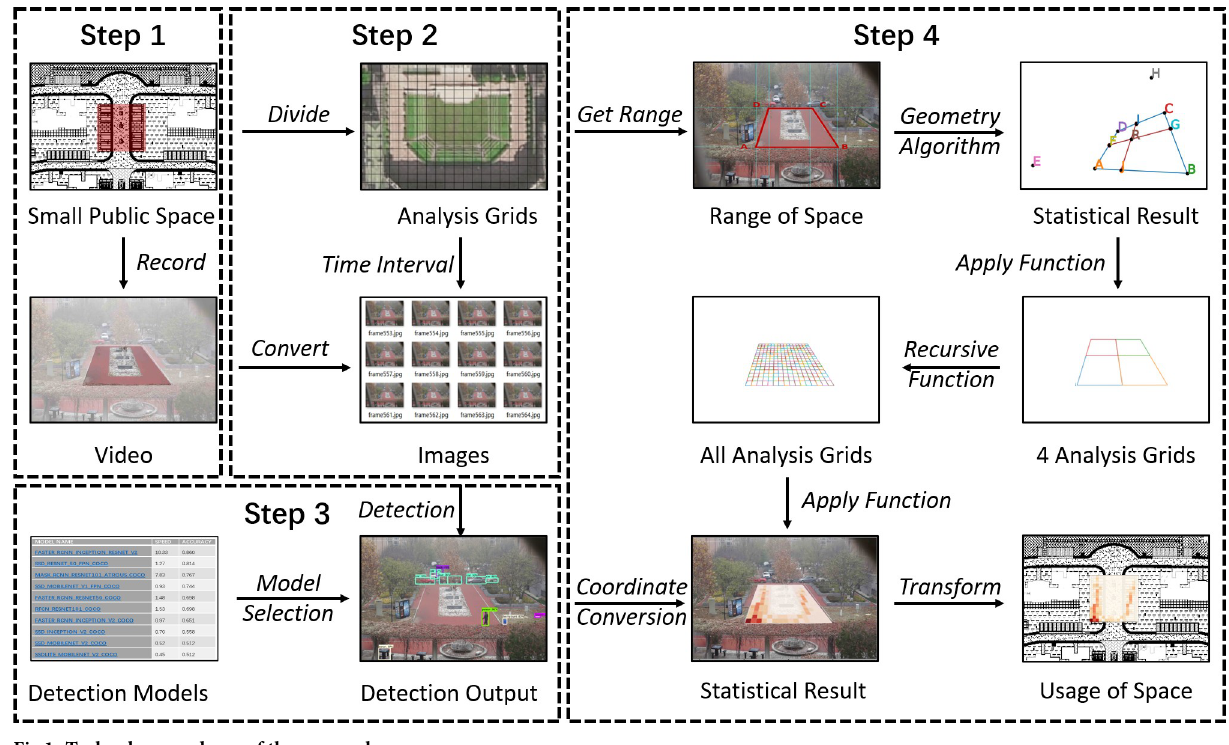
Fig 1. Technology roadmap of the approach.